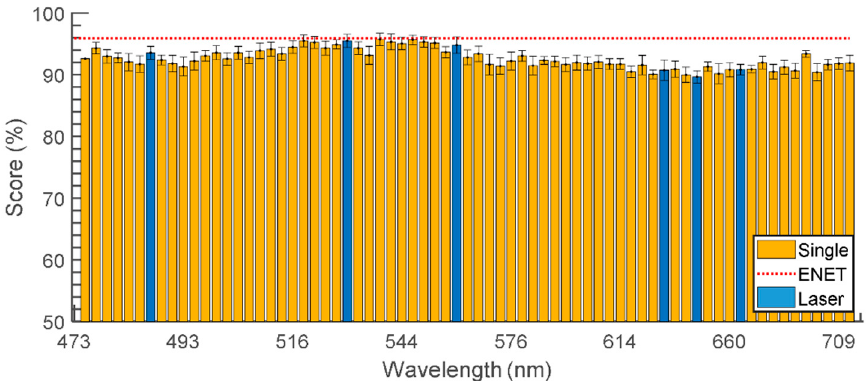
Figure 6. Individual classification scores of SVM-based classifiers using single-wavelength ELS patterns where the bars highlighted in blue represent the common wavelength of diode lasers. The error bars represent the standard deviation. The dotted red line represents the classification score of the elastic net logistic regression model.